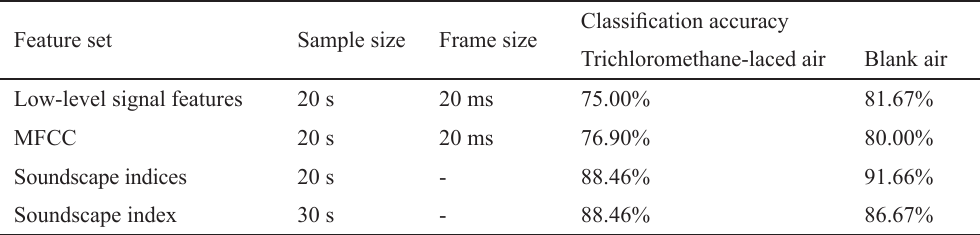
Table 1. Comparison of the discriminative power between three feature sets based on Random Forest. Low-level signal features: spectral centroid (SC), zero-crossing rate (ZCR), mean frequency (meanfreq), and spectral entropy (sp.ent); mel frequency cepstral coefficient (MFCCs): C[1], C[3], C[7] and C[5]; Soundscape indices: Acoustic Complexity Index (ACI), Acoustic Diversity Index (ADI), Acoustic Evenness Index (AEI), and Bioacoustic index